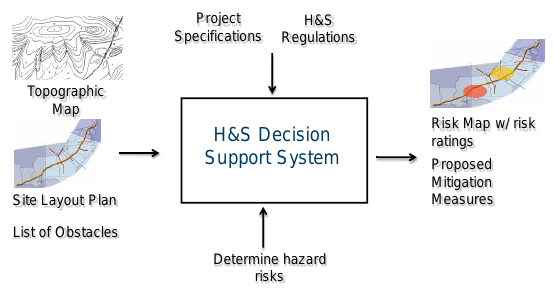
Figure1. IDEF0 model of the proposed H&S